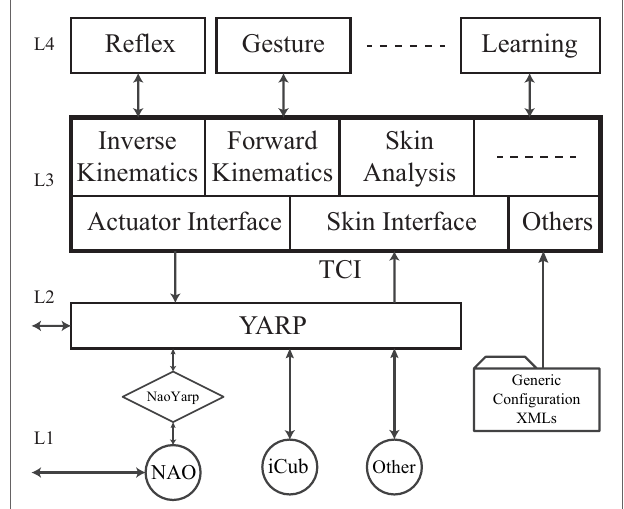
FIGURE 2 | The layered architecture of TCI . L1 and L2 are the low-level robotic controller layers and the YARP middleware layer, respectively. The tactile capabilities interface is defined in L3, which is followed by L4 that consists of reusable cross-platform